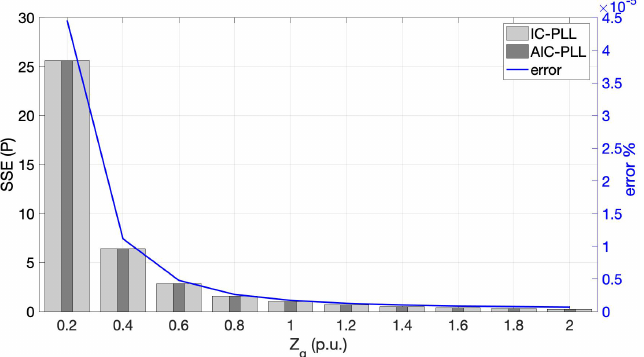
Figure 15. SSE for the active power tracking for the IC-PLL- and AIC-PLL-based system for half value of the maximum power (rectifier operation).